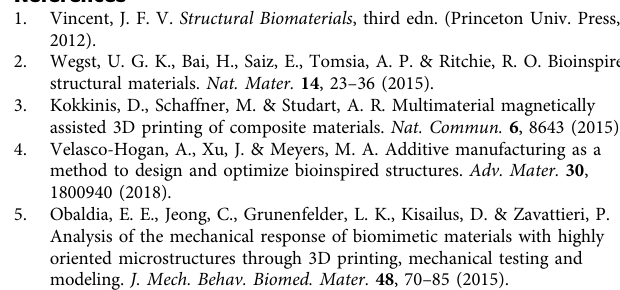
Supplementary Fig. 2. Nonlinear elastic-fracture mechanics-based R-curve measurements were employed to evaluate the fracture toughness. This method can not only quantify the material ’ s resistance to the onset of crack extension, but also to subsequent crack growth. The samples were loaded in uniaxial tension using the MTS Lanmark 370.25 machine under a displacement control mode at a fi xed stress intensity rate of 1 MPa m 0.5 s − 1 . The crack growth was determined using the single-specimen method where repeated unloading/reloading sequences were applied to produce stepwise crack extension 59 . The crack lengths were calculated from the elastic compliance measured during the unloading cycles. To establish the R-curve for a given specimen, the J -integral corresponding to a speci fi c crack length a ( i ) at the i th unloading/reloading cycle can be divided into the elastic component J el ð i Þ and plastic component J pl ð i Þ as J ð i Þ ¼ J el ð i Þ þ J pl ð i Þ 59